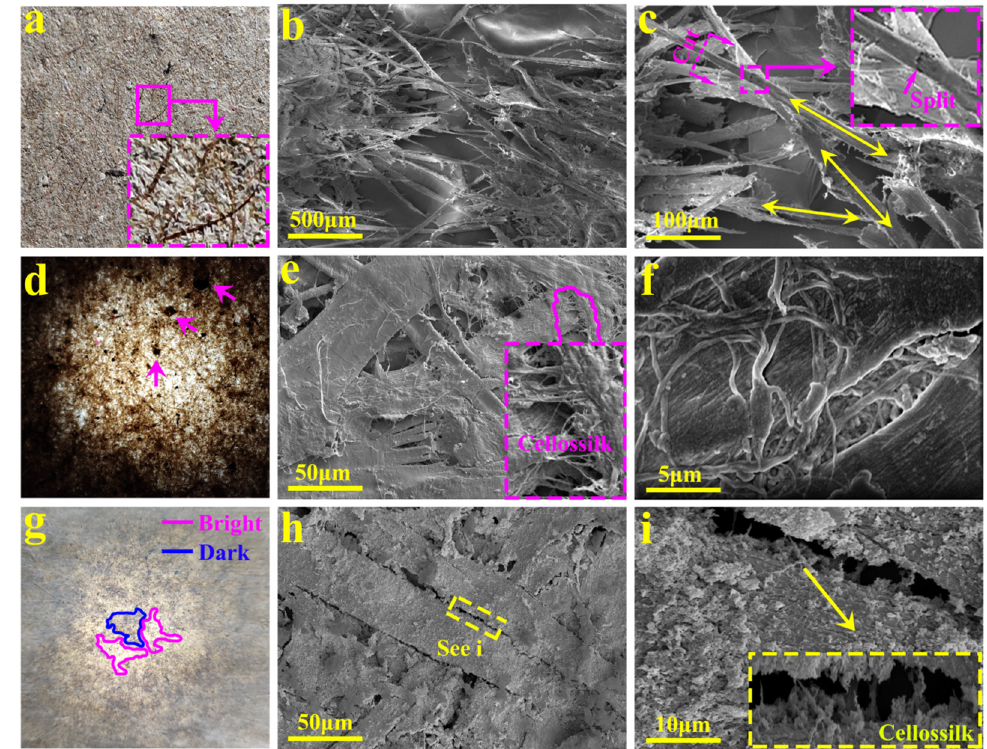
Figure 11. ( a ) Macroscopic view of base paper mulch film, ( b ) Microscopic view of base paper mulch film fracture, ( c ) Enlarged microscopic view of base paper mulch film fracture, ( d ) Microscopic view of base paper mulch film fracture fiber, ( e ) Low magnification electron microscope image of the fractured fibers of the base paper mulch film, ( f ) Microscopic view of base paper mulch film fracture fiber, ( g ) Microscopic view of coated paper mulch film fracture, ( h ) Microscopic view of coated paper mulch film fracture fiber, ( i ) Enlargement electron microscopy of fiber fracture of coated paper film.